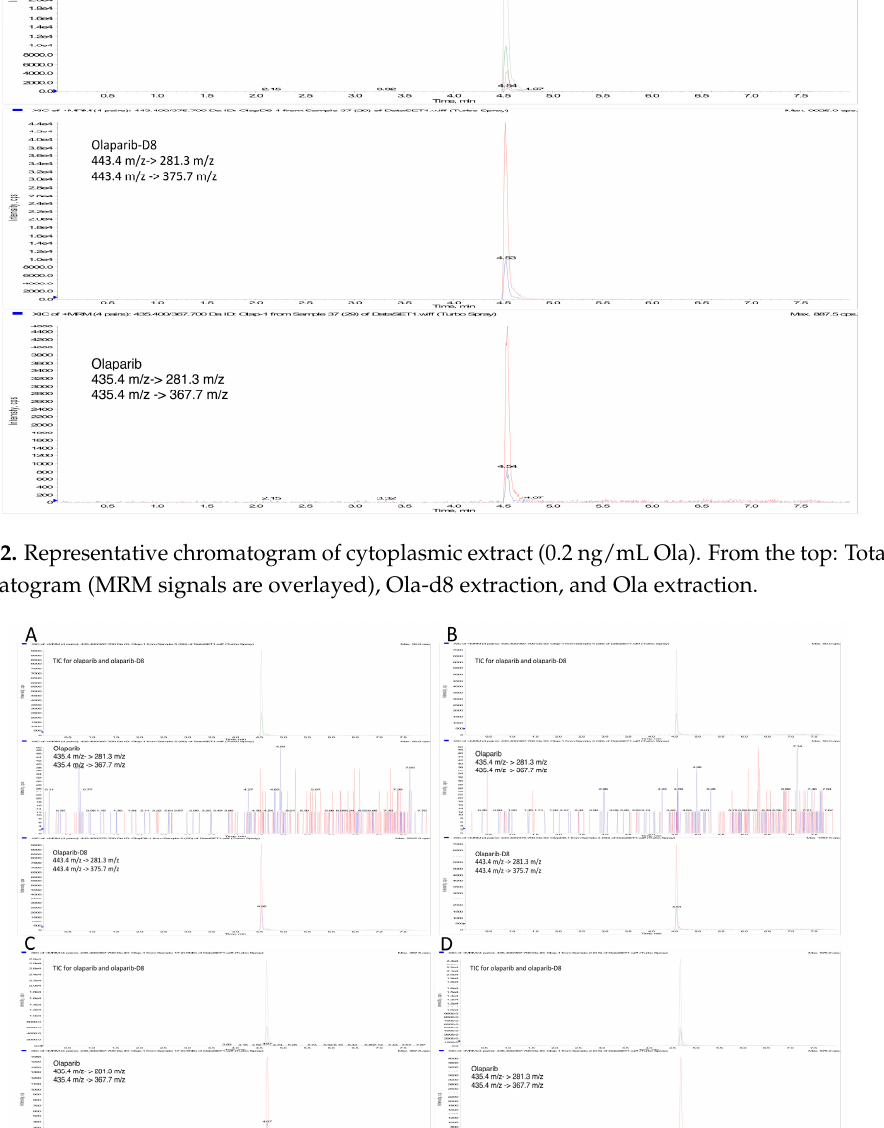
Figure 4. Application of the method. Concentrations expressed in ng/mL of nuclei and cytoplasmic fraction of HCC1937 cells treated with free or encapsulated Ola. 3. Discussion